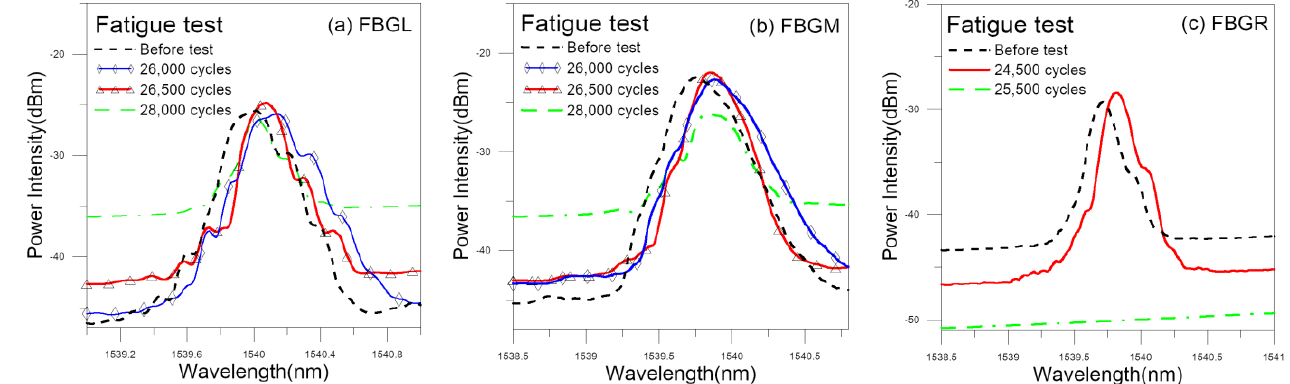
Figure 10. Load-free spectra measured in a typical fatigue specimen after various loading cycles.